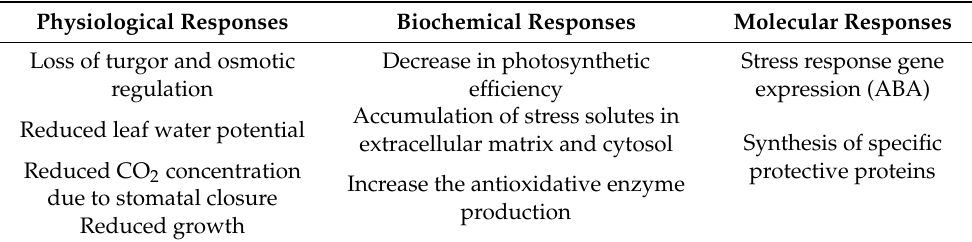
Table 1. Synthetic presentation of physiological and molecular changes of drought-tolerant plants induced during water